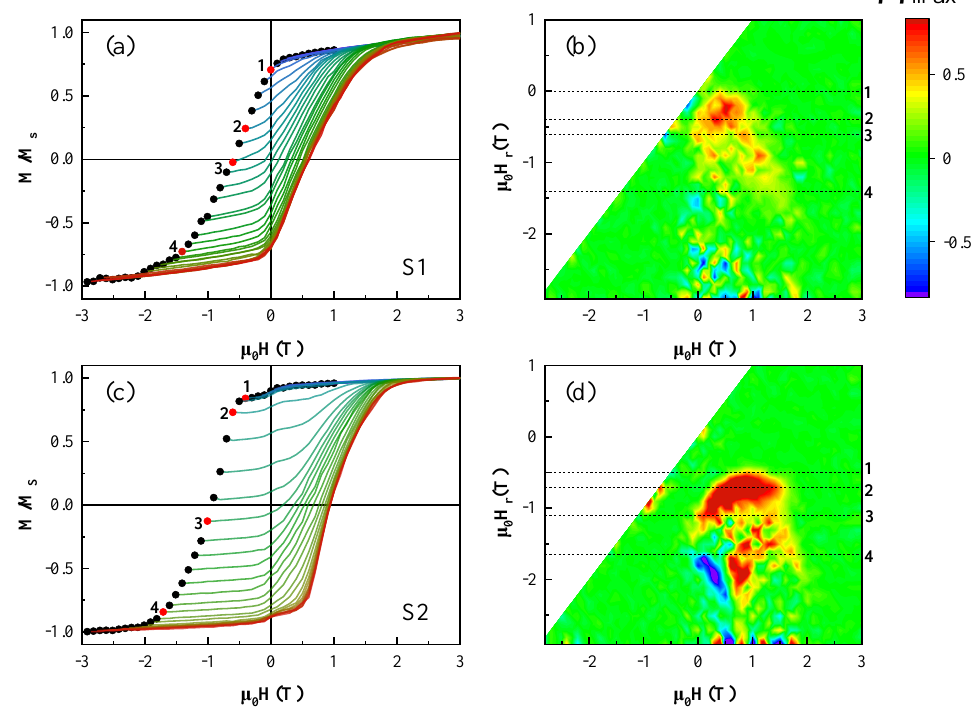
Figure 7. ( a , c ) FORC (normalized to 1) along OOP direction of the S1 and S2 samples; ( b , d ) are the contour plots of the µ 0 H r and µ 0 H dependence of FORC function distribution,